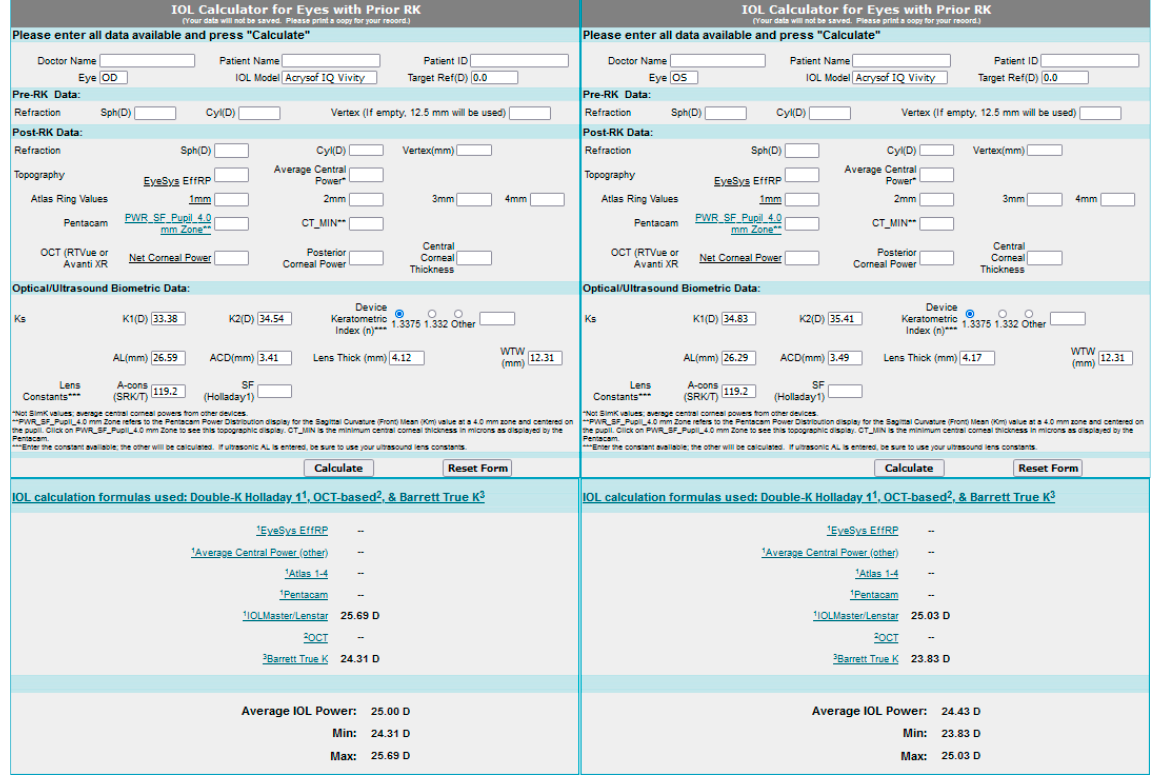
Figure 5. Result of intraocular lens power calculation using ASCRS calculator for the right and the left eye.